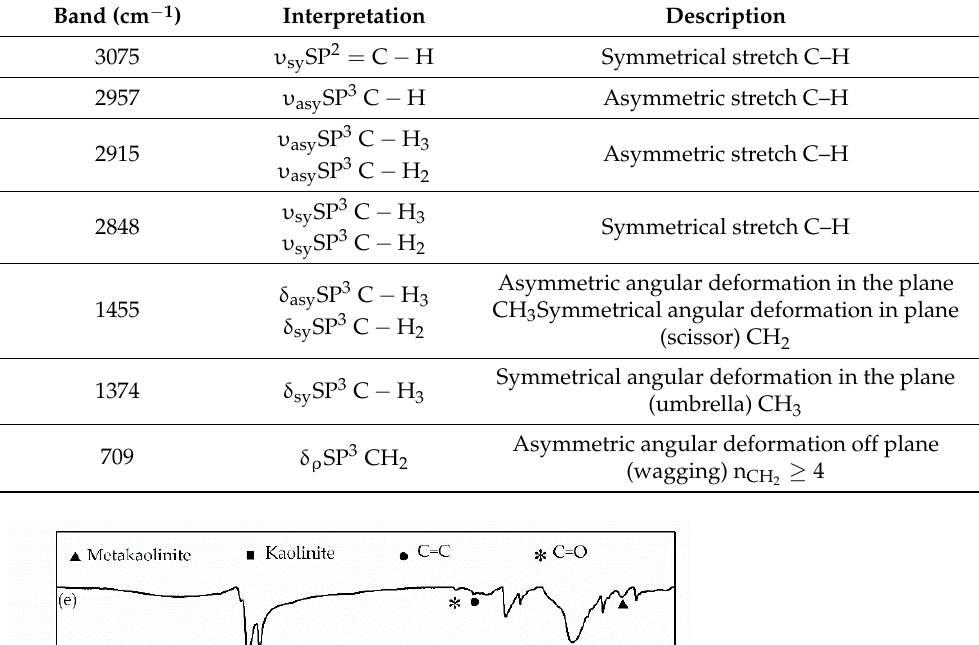
Table 1. Vibrational bands of EPDM.